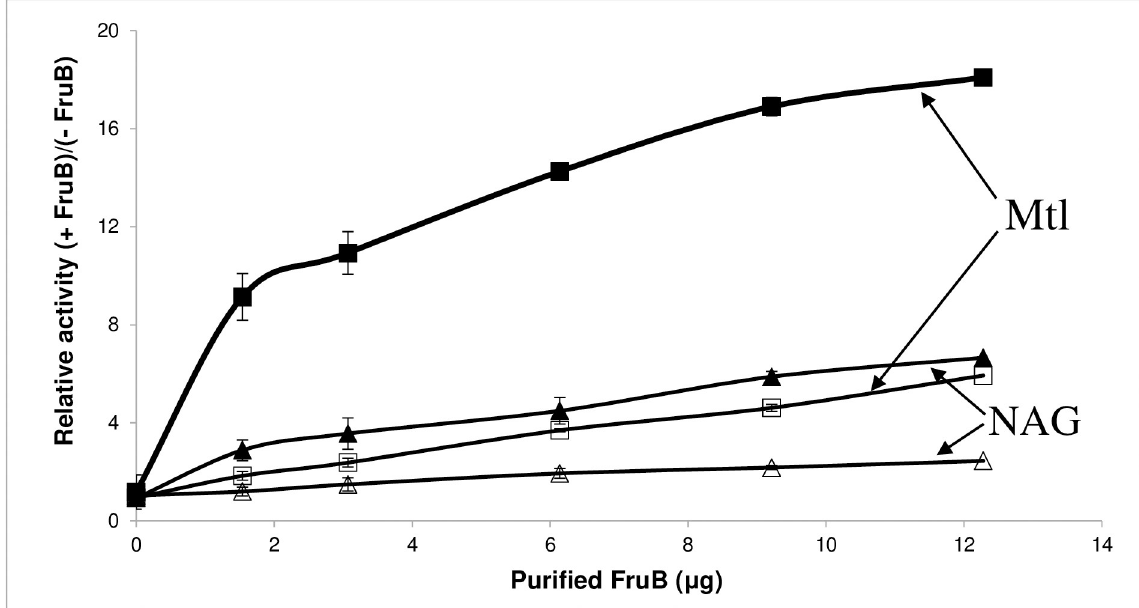
Fig 5. Effect of purified FruB on PEP-dependent phosphorylation activities of crude extracts of the recombinant triple mutant E . coli strain BW25113- fruBKA : kn -pMAL- fruA (TM-pMAL- fruA , closed symbols) as compared to the BW25113- fruBKA : kn -pMAL(TM-pMAL, open symbols), assaying phosphorylation of [ 14 C]PTS sugars, mannitol (Mtl, squares) and N-acetylglucosamine (NAG, triangles). The raw data are presented in S23 Table.